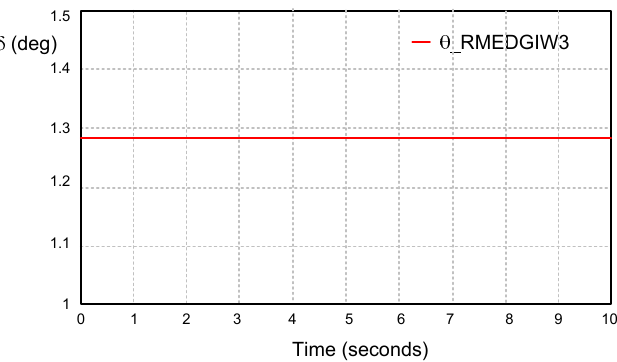
Figure 14. Internal angles of synchronous wind power generators in case of short-circuit on a 110 kV line.